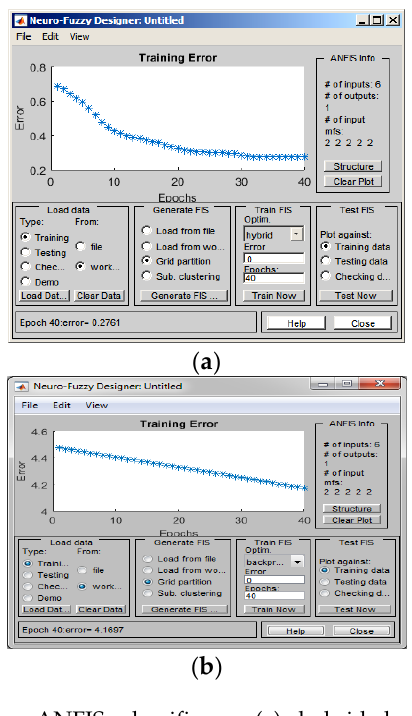
Figure 8. Training of the ANFIS classifier. ( a ) hybrid learning algorithm; ( b ) back propagation algorithm.